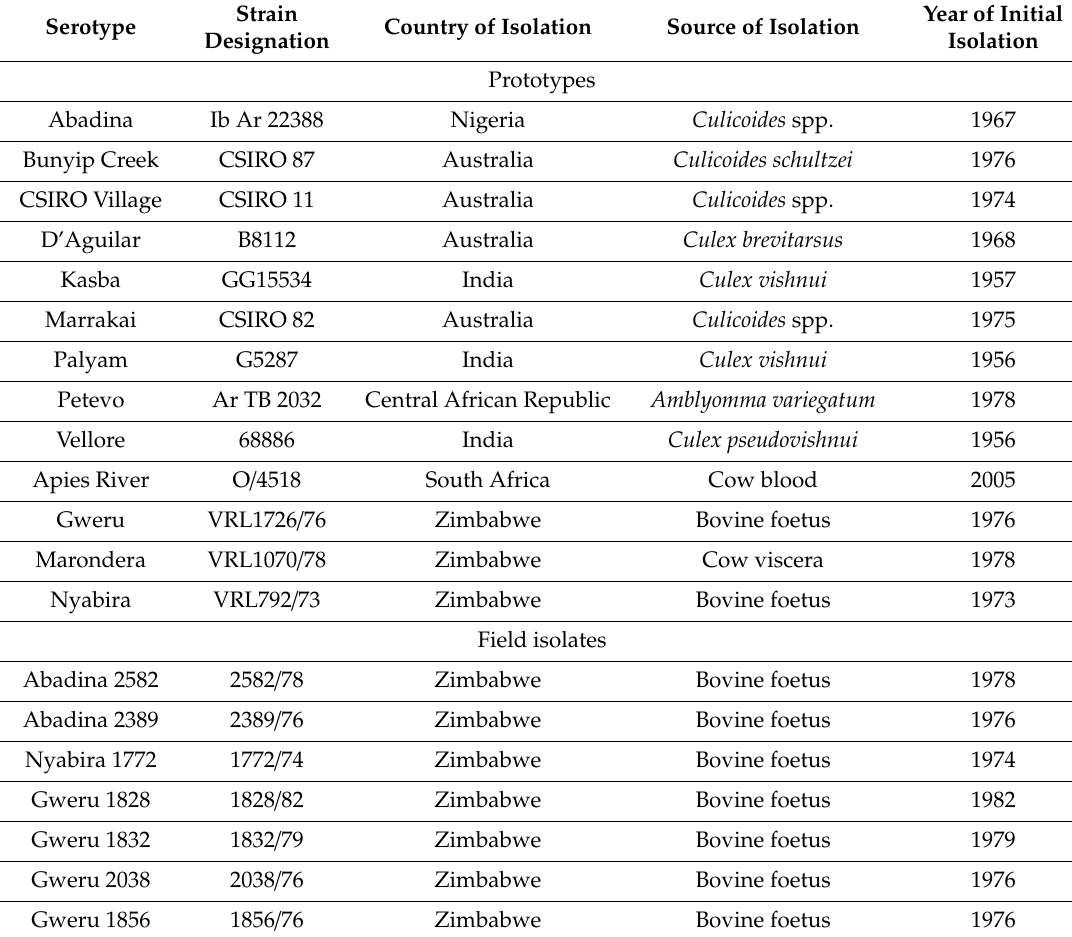
Table 1. Palyam virus isolates used in the